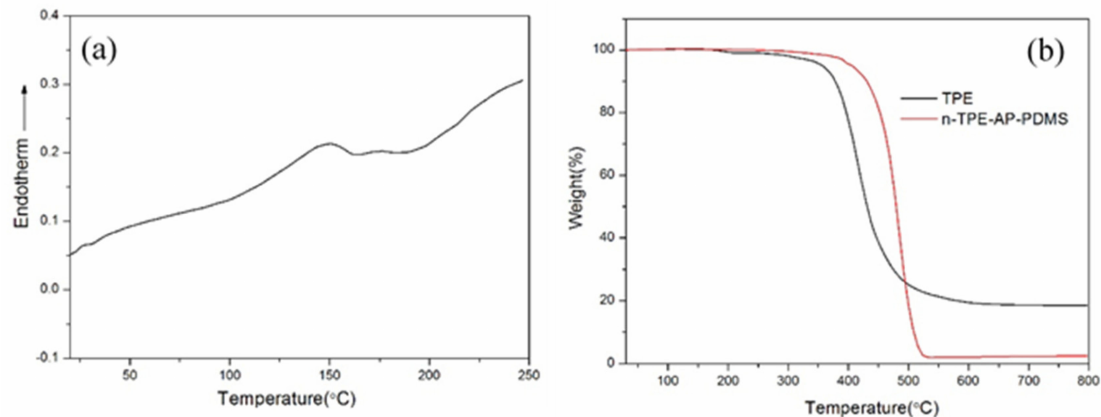
Figure 1. ( a ) DSC trace of n-TPE-AP-PDMS; ( b ) TGA trace of n-TPE-AP-PDMS and n-TPE recorded at a heating rate of 10 ◦ C · min − 1 under nitrogen atmosphere.